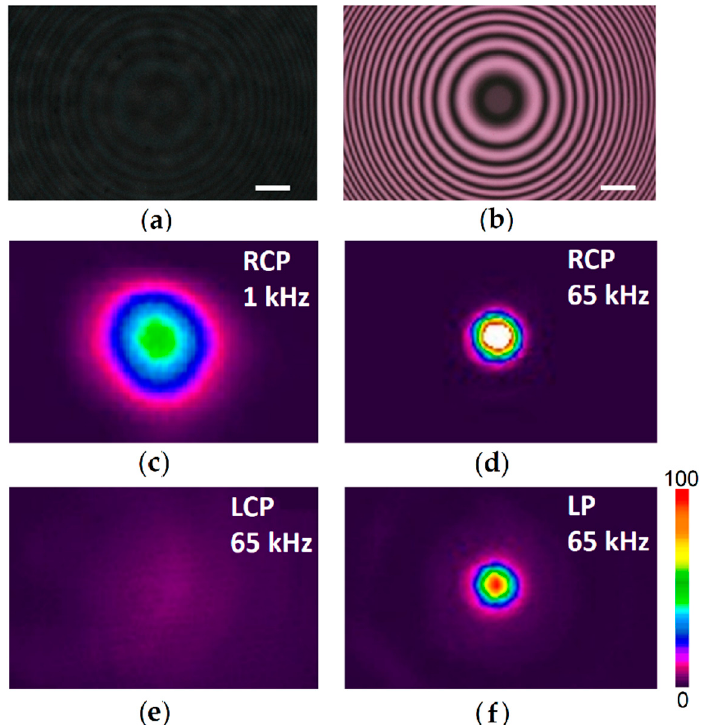
Figure 4. The microscope images of the PB lens under crossed polarizers in the applied voltage 25 V with the frequency of ( a ) 1 kHz and ( b ) 65 kHz, and the images of diffraction patterns at 25 V, 1 kHz of ( c ) right circular polarization (RCP), and at 25 V, 65 kHz of ( d ) RCP, ( e ) left circular polarization (LCP) and ( f ) linearly polarized incident beams. The scale bar is 200 µ m. The colored scale bar shows the normalized intensity gradient.